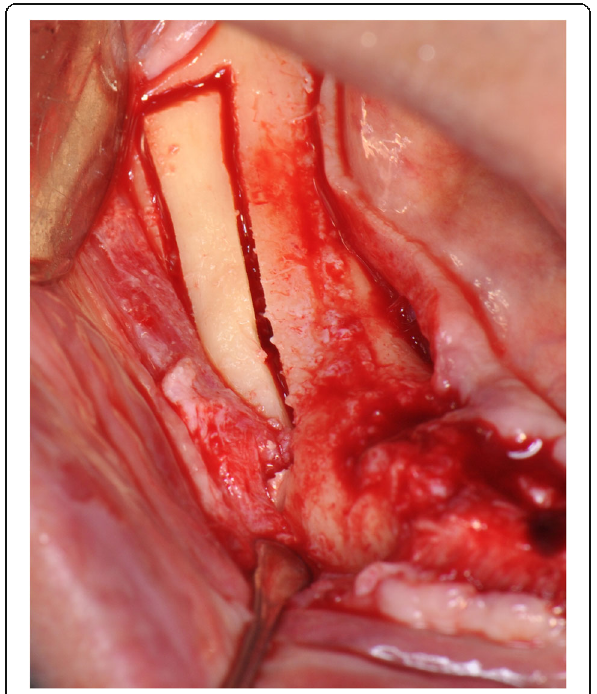
Fig. 3 A full corticotomy is performed creating a rectangular bony window lateral to the inferior alveolar canal